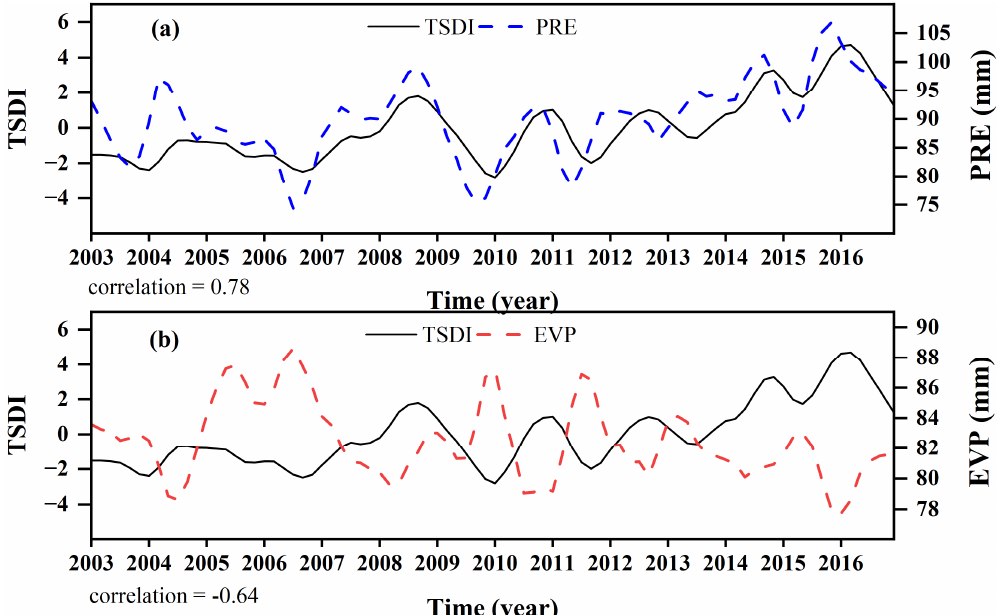
Figure 10. Trend comparison between climate indicators and TSDI. ( a ) precipitation and TSDI; ( b ) evaporation and